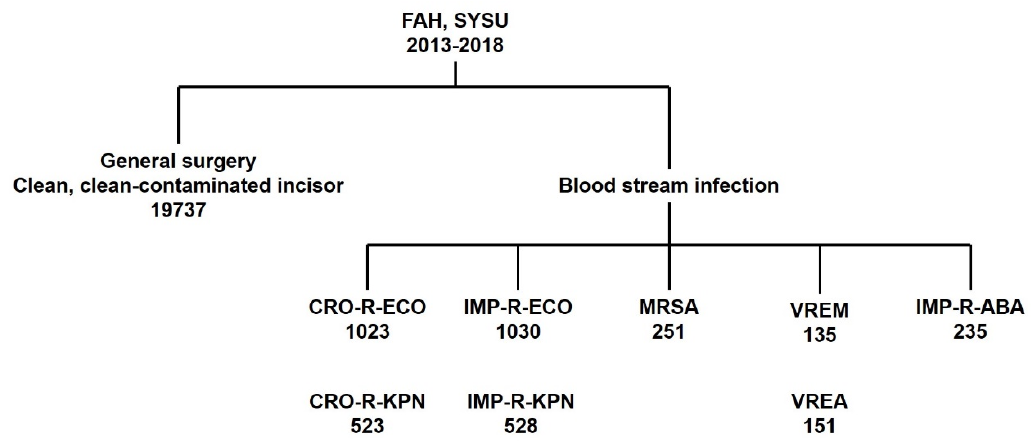
Figure 6. Patient inclusion chart.